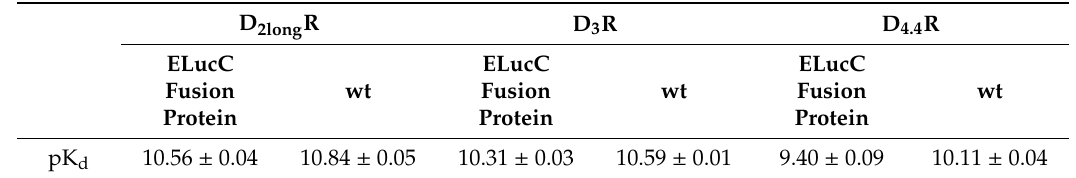
Table 1. Dissociation constants (p K d values) of [ 3 H] N -methylspiperone determined in radioligand saturation binding experiments at receptors fused to the C-terminal fragment of the Emerald luciferase using whole cells and at wild-type receptors using homogenates. Data represent means ± SEM determined in three independent experiments, each performed in triplicate.